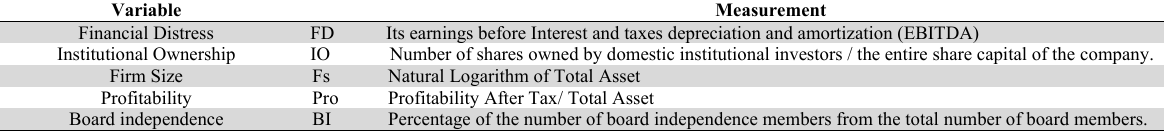
Research Variables Variable